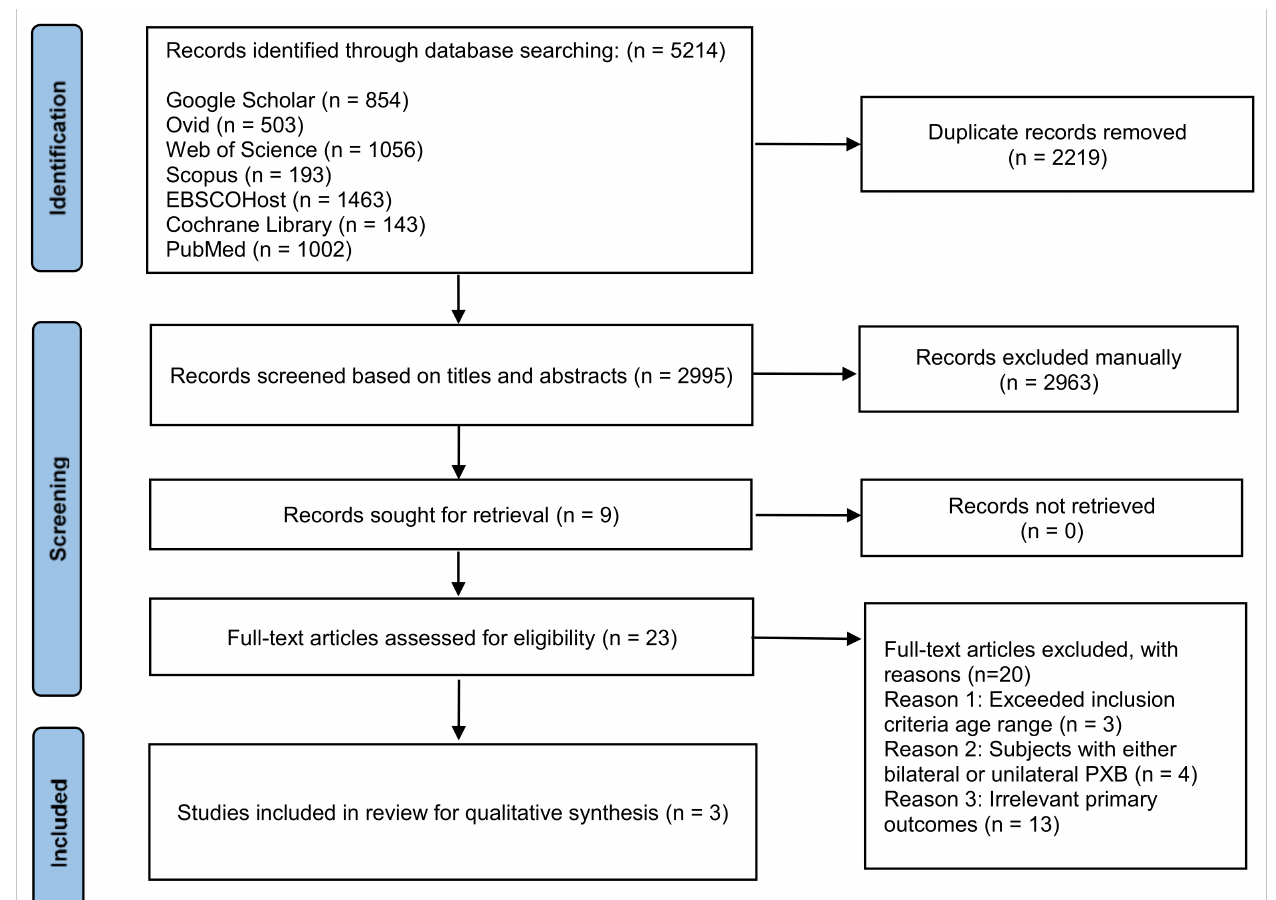
Figure 1. Study selection based on PRISMA